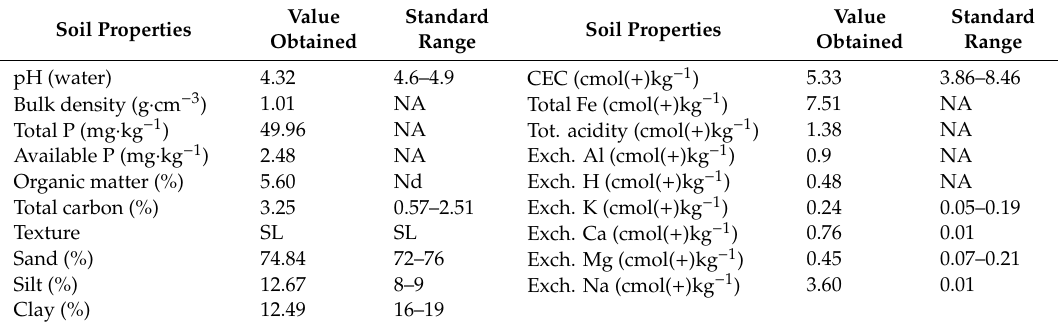
Table 4. Selected physico-chemical properties of the Bekenu